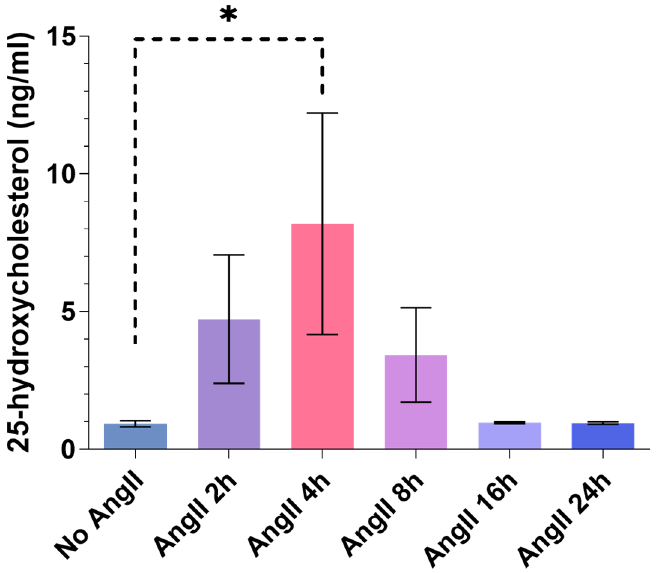
Figure 6. The 25-HC content of AngII-stimulated rat VSMC supernatant. Serum-deprived VSMCs were stimulated with 1 μ M AngII for 2, 4, 8, 16, and 24 h or not stimulated. A total of 1 mL of supernatant of the cells was collected and subjected to LC-MS/MS analysis in order to identify 25-HC content and concentration. The 25-HC concentration is expressed in ng/mL. Concentration values are plotted as the mean ± SEM of n = 3 independent experiments. Data were analyzed using multiple linear regression, * p < 0.05.